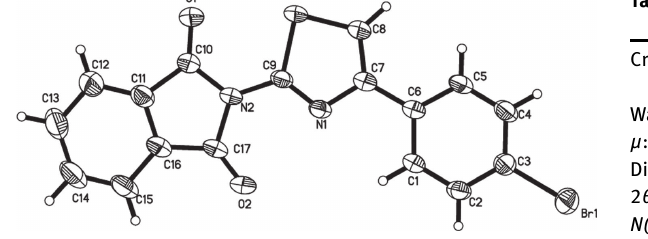
Table 1: Data collection and handling.